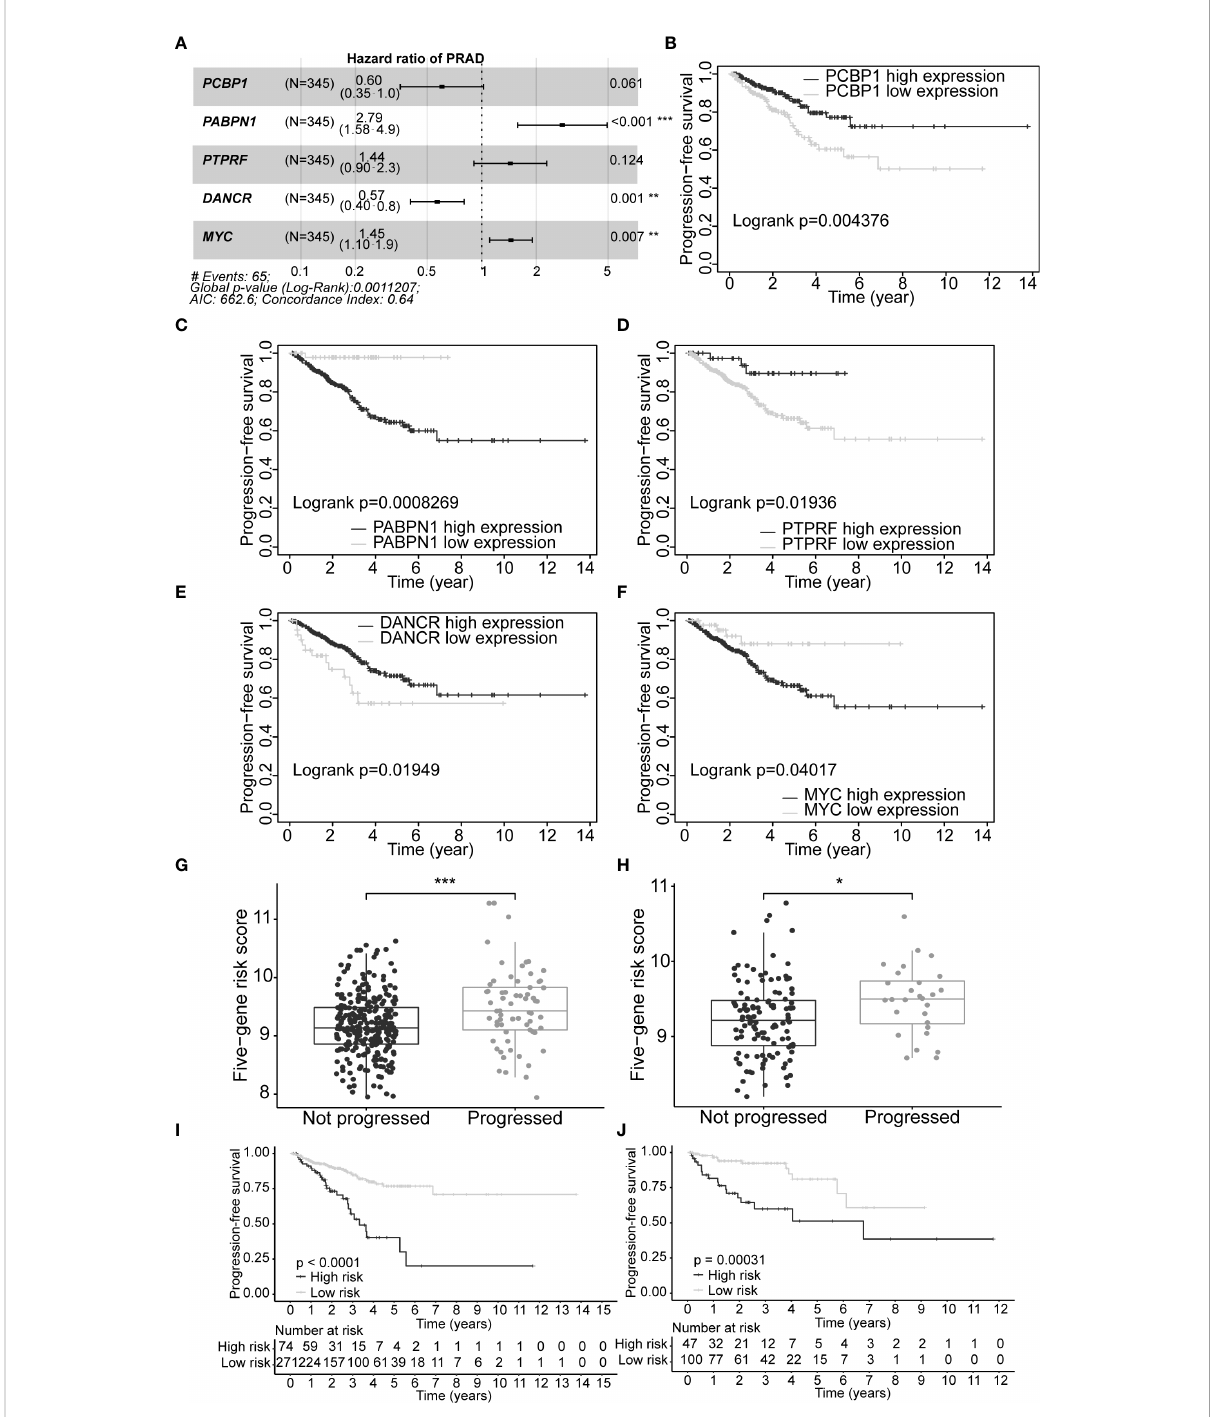
FIGURE 4 Construction of optimal gene signature and performance of the PFS survival risk score model. (A) Forest plot of the fi ve genes in the signature. (B – F) KM survival curves and log-rank test based on gene expression levels for the 5 genes in the signature. Boxplots of the signature risk score between not progressed and progressed PCa patient groups in TCGA-PRAD training set (G) and TCGA-PRAD testing set (H) . The signi fi cance of the risk score difference between the two groups is interpreted as asterisks (ns, no signi fi cance, *p< 0.05, **p< 0.01, ***p< 0.001). KM survival analysis and log-rank test based on the risk scores obtained in TCGA-PRAD training set (I) and TCGA-PRAD testing set (J) . PFS, progression-free survival; KM, Kaplan – Meier; PCa, prostate cancer; TCGA, The Cancer Genome Atlas; PRAD, prostate